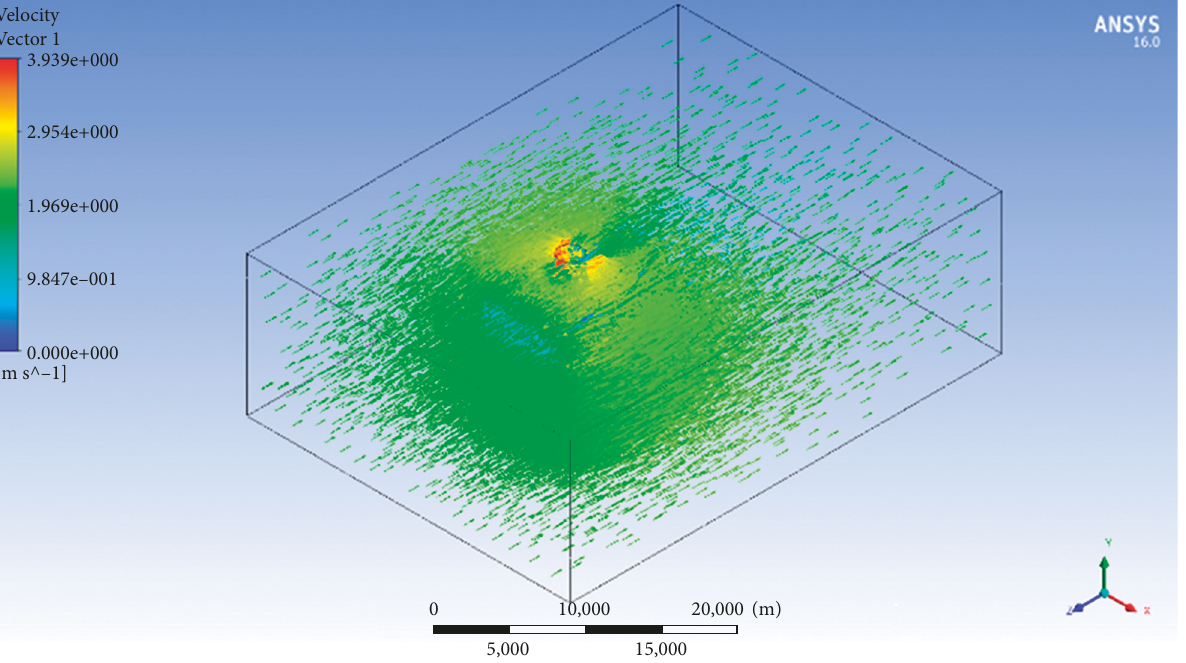
Figure 12: The reference scour scenario for assessment (scour depth of 10 m).